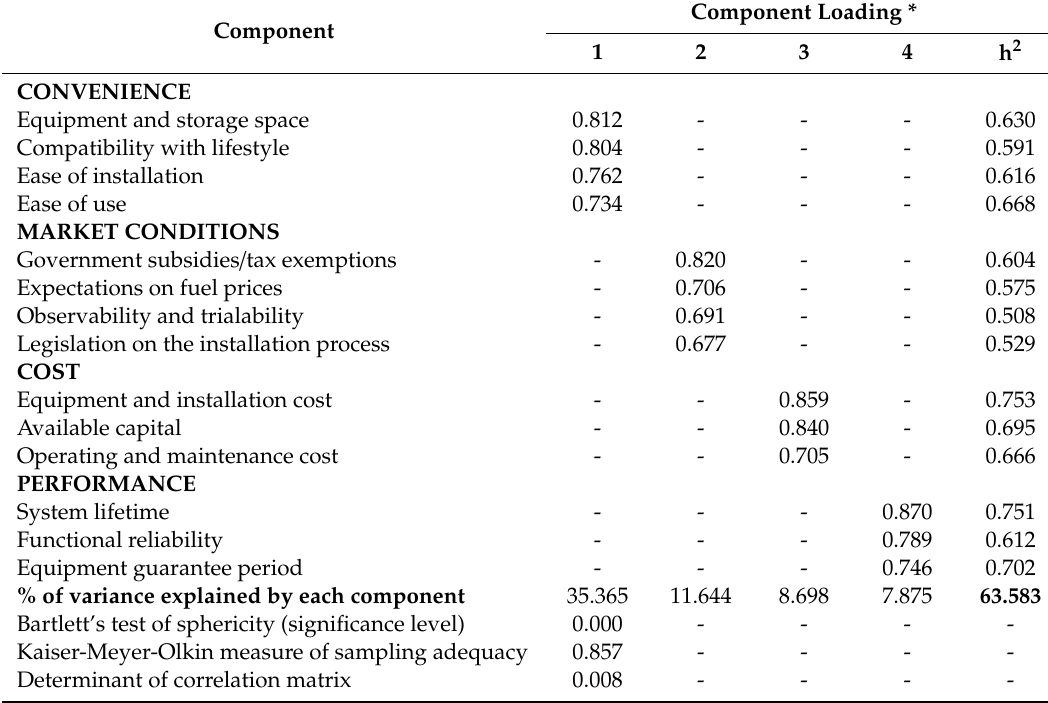
Table 3. Classificationoffactorsrelatedtoconsumers’behavior,